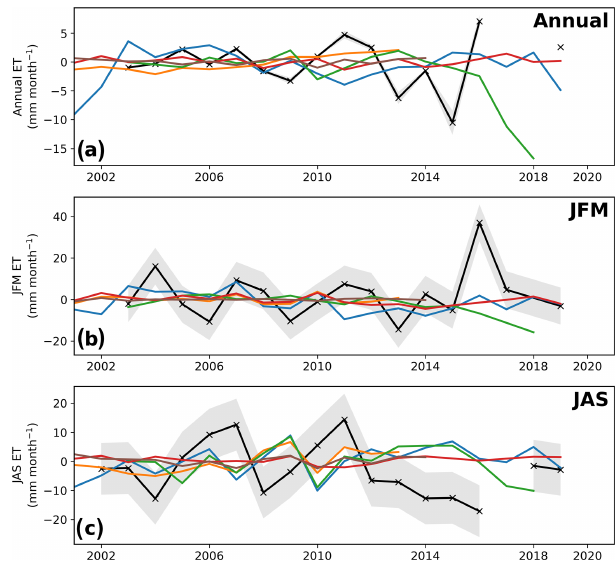
Figure 8. Interannual variation in evapotranspiration (ET) from 2001 to 2019. Time series in ET over the Amazon from catch- ment balance (black, region drained by Óbidos; Fig. 1), satellites (MODIS, P-LSH, and GLEAM), ERA5 reanalysis, and CMIP6 models for (a) the whole year, (b) January–March (JFM), and (c) July–September (JAS), normalised by the 2003–2013 climato- logical mean. Interannual trends are listed in Table 3. Grey shad- ing indicates the interannual standard deviation in the catchment- balance